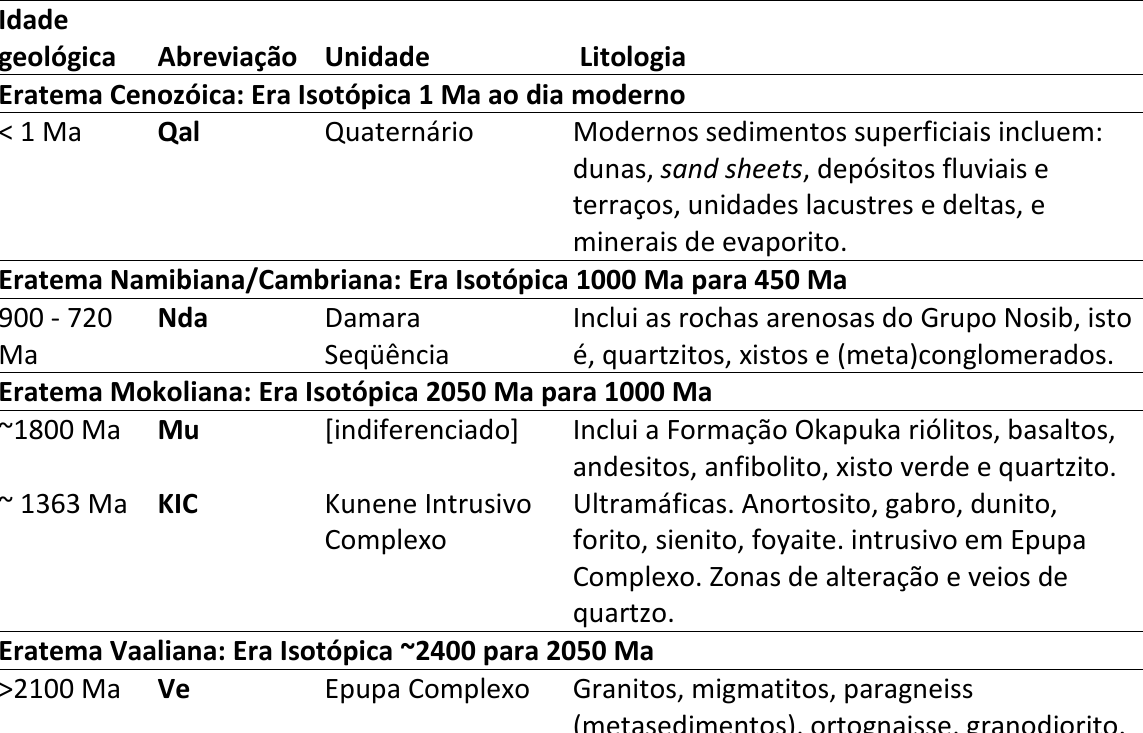
Table 3. Primary geological units in the studied area next to Cafema. Ma = millions of